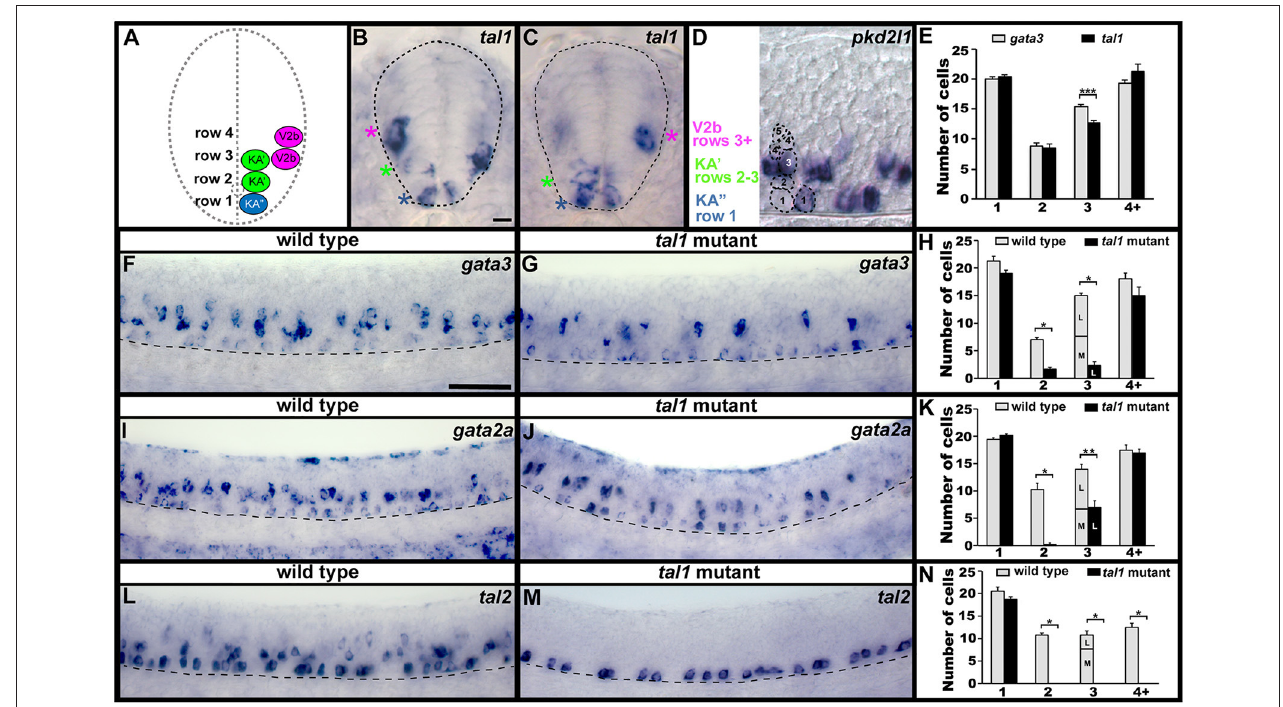
FIGURE 1 | Spinal expression of tal1 and requirement in KA and V2b neurons. Cross-sectional (A–C) and lateral (D,F,G,I,J,L,M) views of 24h zebrafish embryos. Dorsal, top; in lateral views, anterior, left. (A) Schematic indicating positions of KA ′′ , KA ′ , and V2b neurons. (B,C) tal1 expression in KA ′′ (blue asterisks), KA ′ (green asterisks), and V2b (magenta asterisks) cells. (D) Example of counting cells in different dorsal/ventral (D/V) “rows” (see section Materials and Methods). Row 3 contains both medial KA ′ cells and lateral V2b cells. V2b cells are also located in row 4 and above. (E,H,K,N) Mean number of cells expressing specific genes in each D/V row of precisely-defined spinal cord region adjacent to somites 6–10. The approximate proportions of medial and lateral row 3 cells are indicated by horizontal lines separating the number of medially-located cells (bottom and indicated with an “M”) from the number of laterally-located cells (top and indicated with a “L”). All of the remaining gata3- and gata2a -expressing cells in row 3 of tal1 mutants were located laterally and were pear shaped, consistent with them being V2b cells, suggesting that no KA ′ cells express these genes in tal1 mutants. tal1 and gata3 expression in 24h WT embryos (E) . gata3 (F–H) , gata2a (I–K) , and tal2 (L–N) expression in WT siblings and tal1 mutants. Dashed lines indicate spinal cord boundary (A–C) or ventral limit of spinal cord (F,G,I,J,L,M) . gata2a expression ventral to spinal cord and in dorsal trunk is excluded from cell counts (I) . Scale bars (B) = 10 microns (B–D) ; (F) = 50 microns (F,G,I,J,L,M) . All counts were conducted blind to genotype and are an average of at least 4 embryos. Error bars indicate SEM. Statistically significant ( p < 0.05) comparisons are indicated with brackets and stars. *** P < 0.001, ** P < 0.01, * P < 0.05. P-values are provided in Supplementary Table